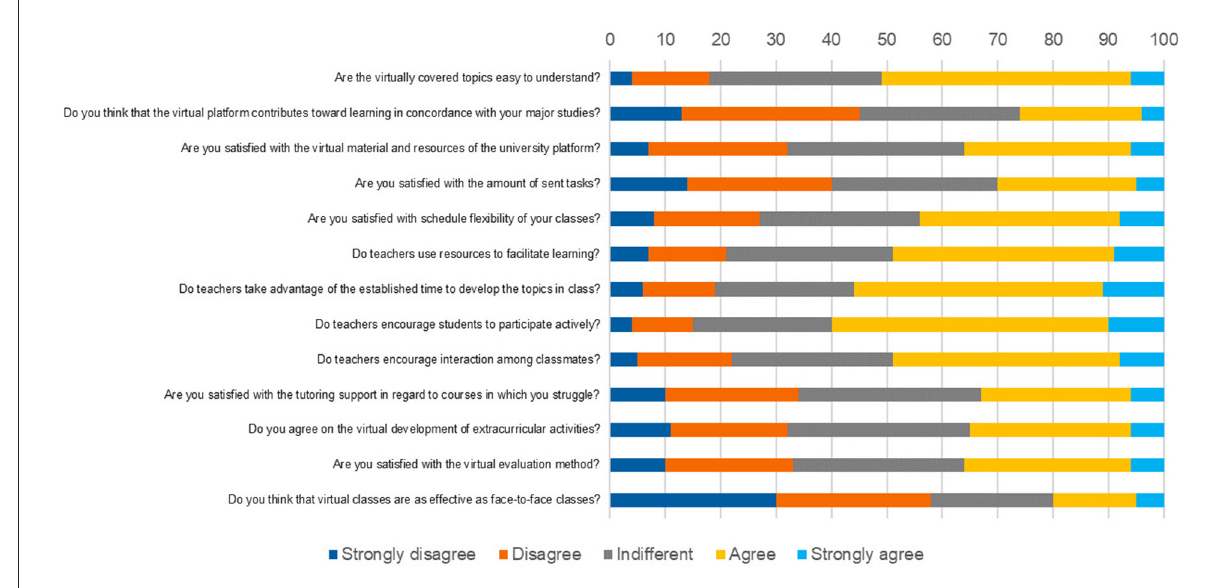
FIGURE1 Perception of satisfaction with virtual classes among Peruvian medical students ( n =